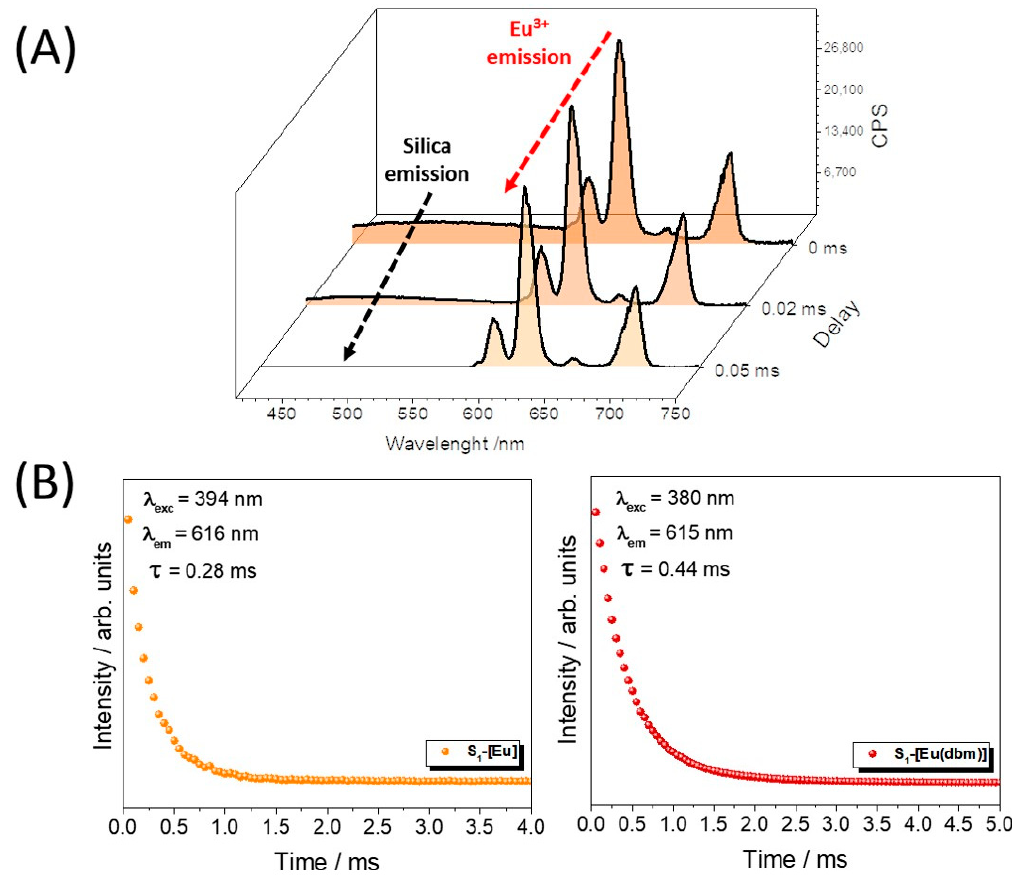
Figure 6. ( A ) Time-resolved emission spectra of S 1 -[Eu] with λ ex = 394 nm; ( B ) 5 D 0 excited state decay curves of S 1 -[Eu] and S 1 -[Eu(dbm)]. Table 2. 5 D 0 excited state lifetime ( τ ), radiative (A rad ) and nonradiative (A nrad ) decay ratios, intrinsic emission quantum yield ( φ Ln ) and the number of coordinated H 2 O molecules ( q H Ln S 1